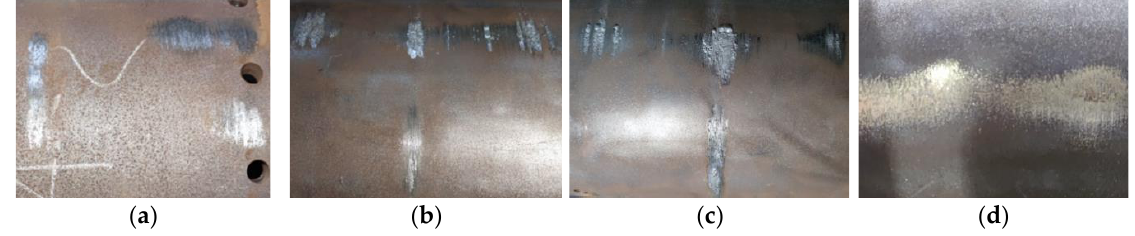
( d ) Figure 9. Wear on the friction surface of the lower arc end-plate of each specimen under an equal amplitude loading protocol: ( a ) H350 − 1 − 2; ( b ) H350 − 2 − 2; ( c ) H350 − 3 − 2;( d ) H350 − 4 − 2. As shown in Figure 10, an enlarged view of the abrasion part of the arc end-plate. the steel plate has an obvious convex abrasion when the axial compression ratio equals 0.3 (in Figure 10c). According to the tribology principle [21]: abrasion refers to the surface dam- age and shedding of two solid surfaces in sliding, rolling, or impact motion. Generally, inter-metal abrasion is divided into abrasive abrasion, adhesive abrasion, surface fatigue abrasion, and corrosion abrasion. In this test, the abrasion between arc end-plates is mainly adhesive wear and abrasive wear. According to the principle of friction [22], the sliding friction between metals is a process of adhesion and sliding alternately, and the